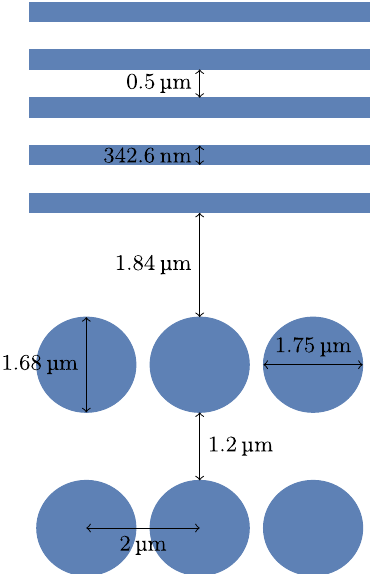
FIG. 14. Dimensions of the dual pillar structure. The structure is made of fused silica ( ε r ¼ 2 . 13 ).